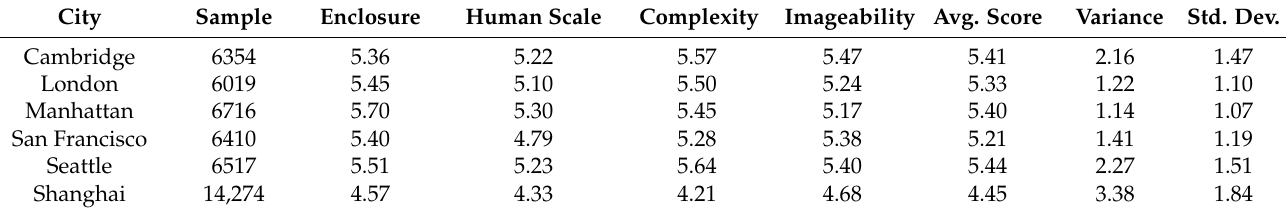
Table 4. Average scores, standard deviation and